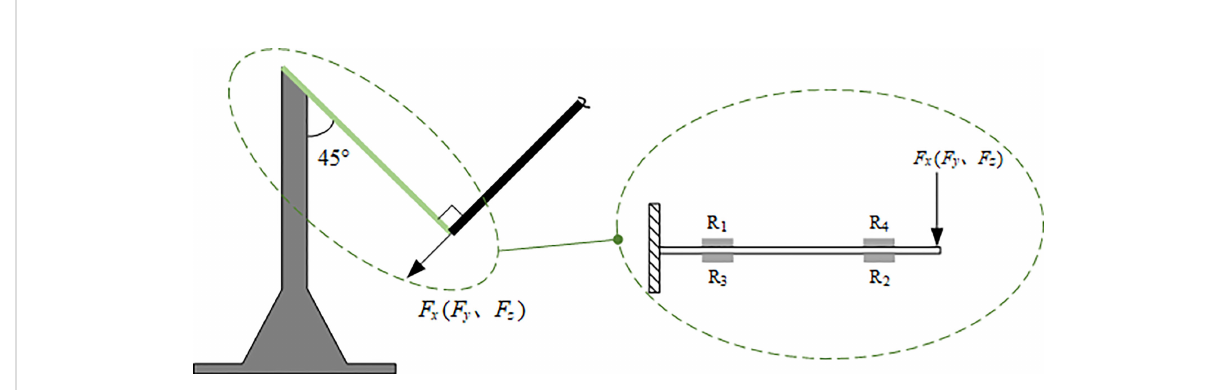
FIGURE 4 The force analysis of the cantilever pieces of the three directions of the Sensing Coordinate System.